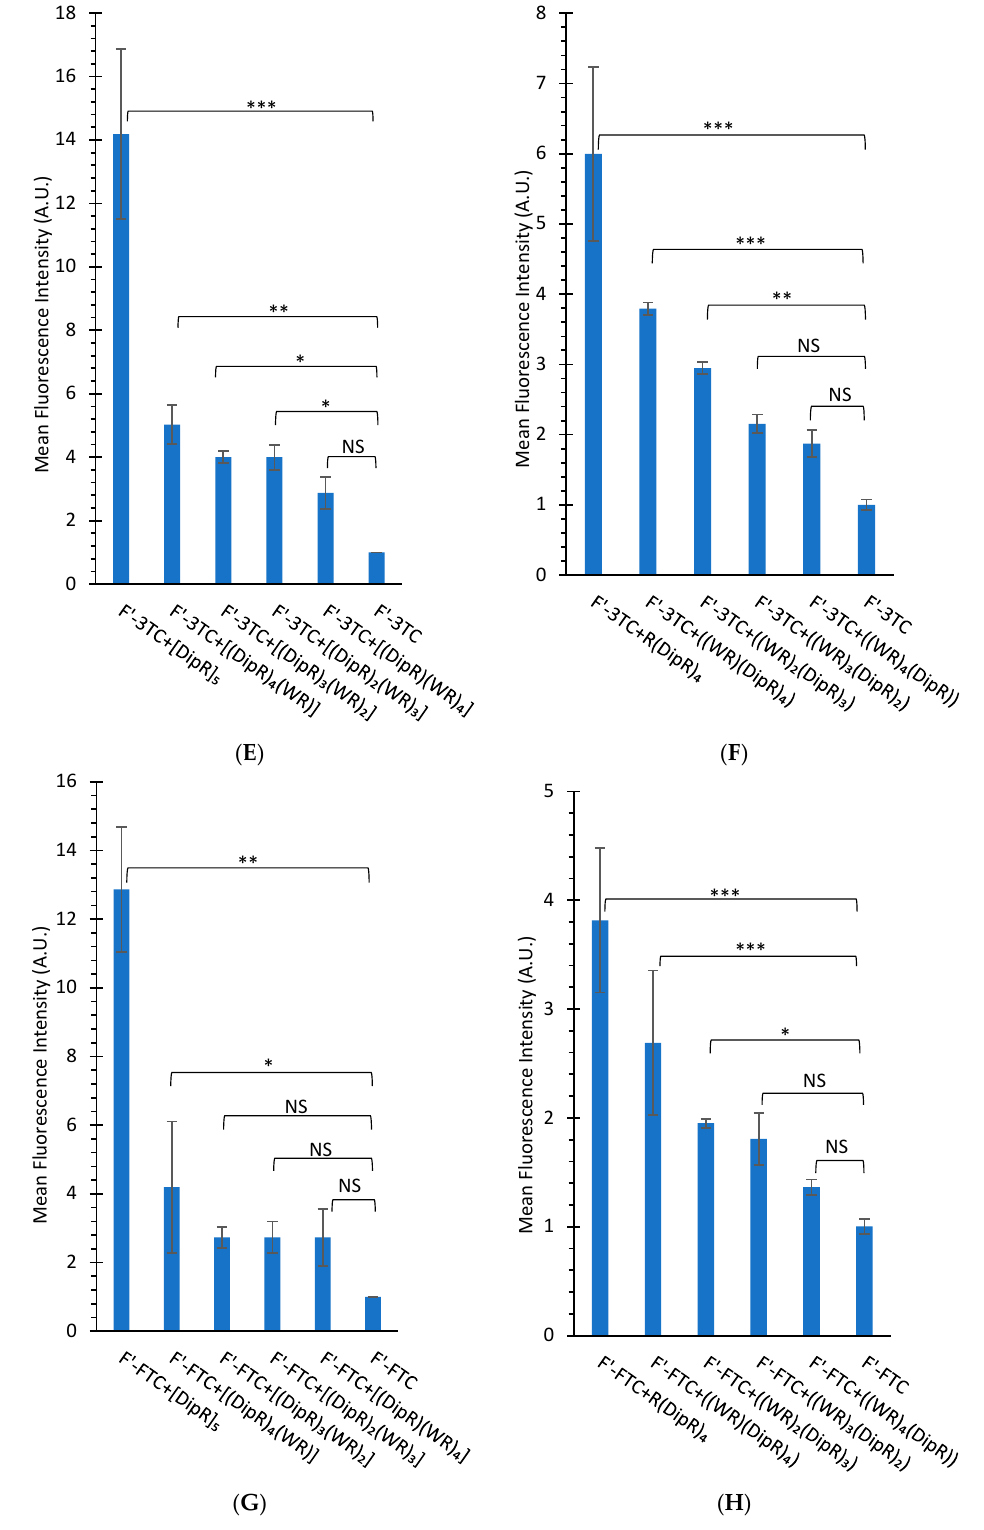
Figure 7. Cellular uptake of F’-GpYEEI (2 µ M), F’-d4T (2 µ M), F’-3TC (2 µ M), and F’-FTC (2 µ M) in the presence of cyclic ( A , C , E , G ) and linear ( B , D , F , H ) peptides (10 µ M) for CCRF-CEM cells after 3 h incubation. Results are mean ± SD (n = 3) (* p < 0.05, ** p < 0.01, *** p < 0.001, NS = Not